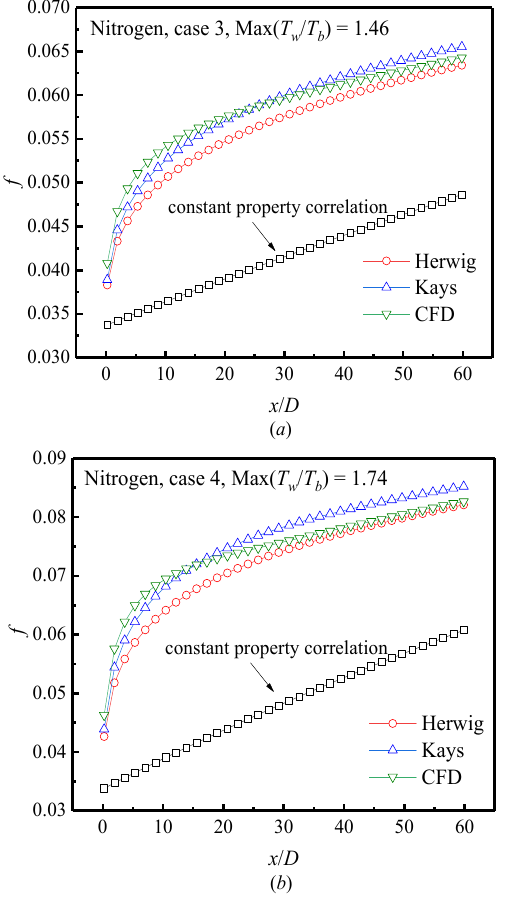
Figure 4. Calculations by existing f correlations for nitrogen. ( a ) case 3; ( b ) case 4. Table 4. Calculation errors of helium by laminar flow f correlations. As shown in Tables 4 and 5, the prediction errors of the three f correlations for helium and nitrogen are calculated based on case 1 and case 3, respectively. It can be found that the prediction error of the constant property correlation is close to 30% in the region of ∆ x / D ≥ 46.2. Under the conditions of different T w / T b and Re number, the calculation errors of Herwig correlation for helium and nitrogen are less than 2.5% and that of